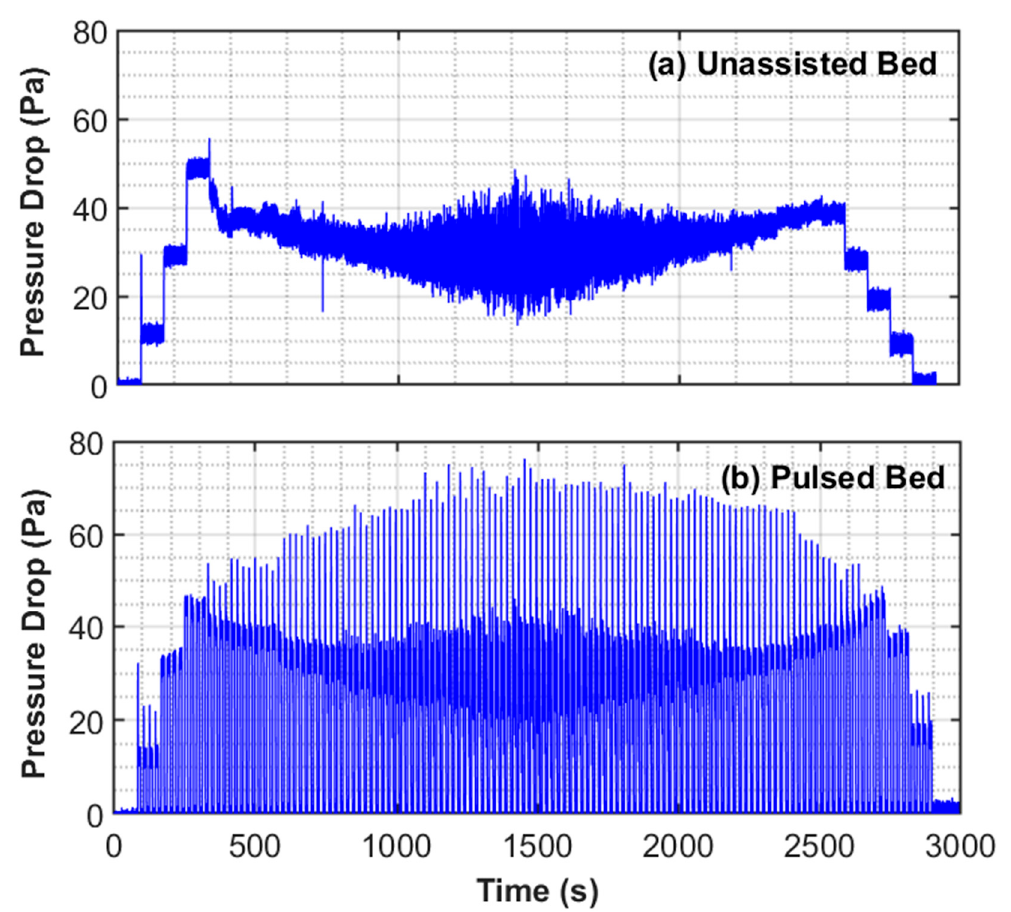
Figure 8. Bed dynamics in the central region of the bed recorded by ∆ P 3 for ( a ) unassisted and ( b ) pulsed fluidization.